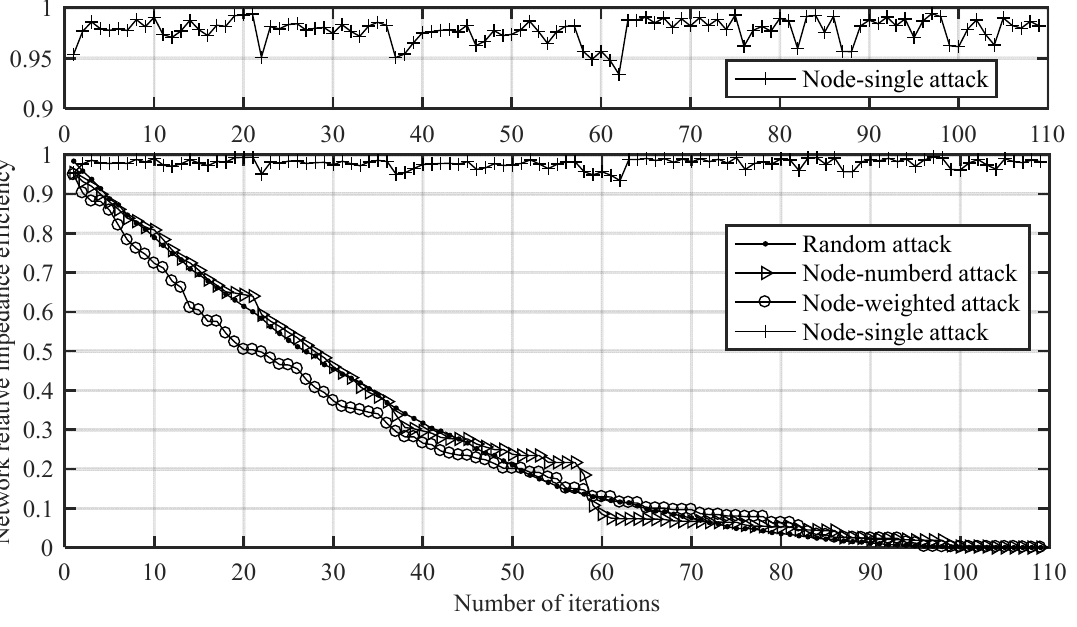
Figure 8. The trend of network performance of attacking nodes deliberately.